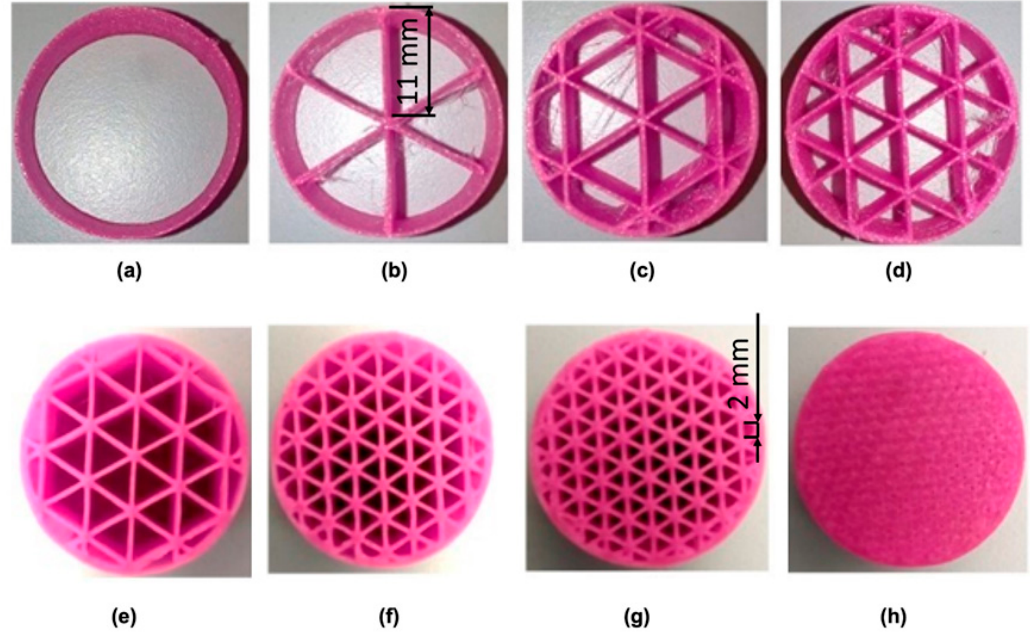
Figure 4. Printed samples, for compression tests, with different filling densities (triangular mesh): ( a ) 0%; ( b ) 10%; ( c ) 15%; ( d ) 20%; ( e ) 25%; ( f ) 40%; ( g ) 50%; ( h ) 100% (dimensions in mm).